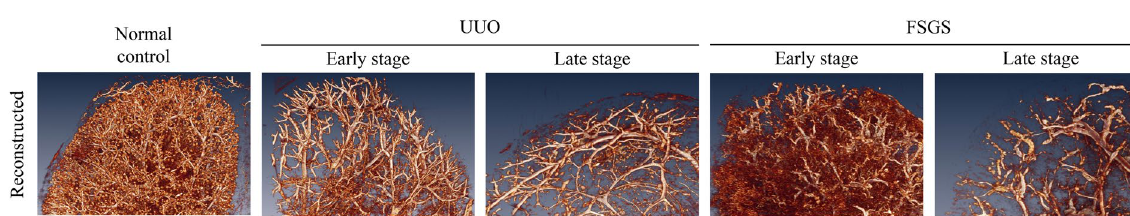
( b ) The quantitative results were shown as the TI lesions score and glomerular lesions score, respectively. ( c ) The quantitative results of Col-III positive area (% per field) in the renal TI lesions and glomerulus. The horizontal dashed line indicates the level of the normal control mice. UUO-unilateral ureteral obstruction; FSGS-focal segmental glomerulosclerosis; TI-tubulointerstitial; Col-III-collagen-III. n = 7 mice per group. * p < 0.05, ** p < 0.01, *** p < 0.005.